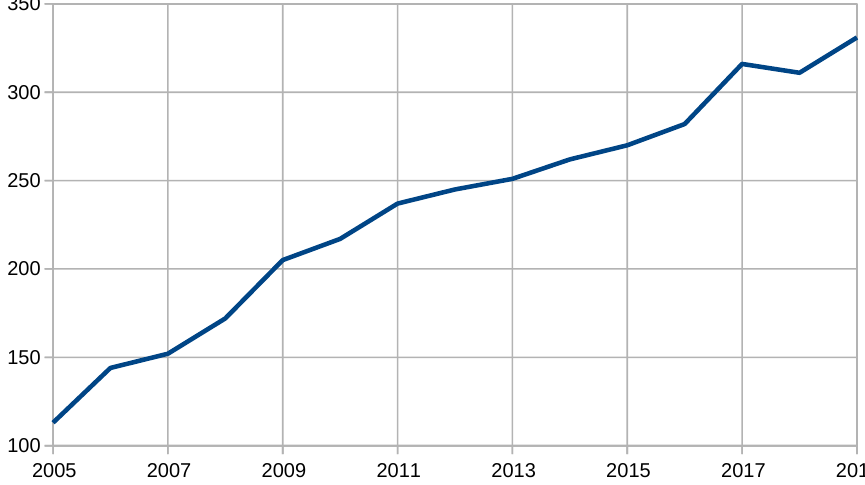
Figure 3. Number of publications on insect radar from 2000 to 2020 (one-year interval).